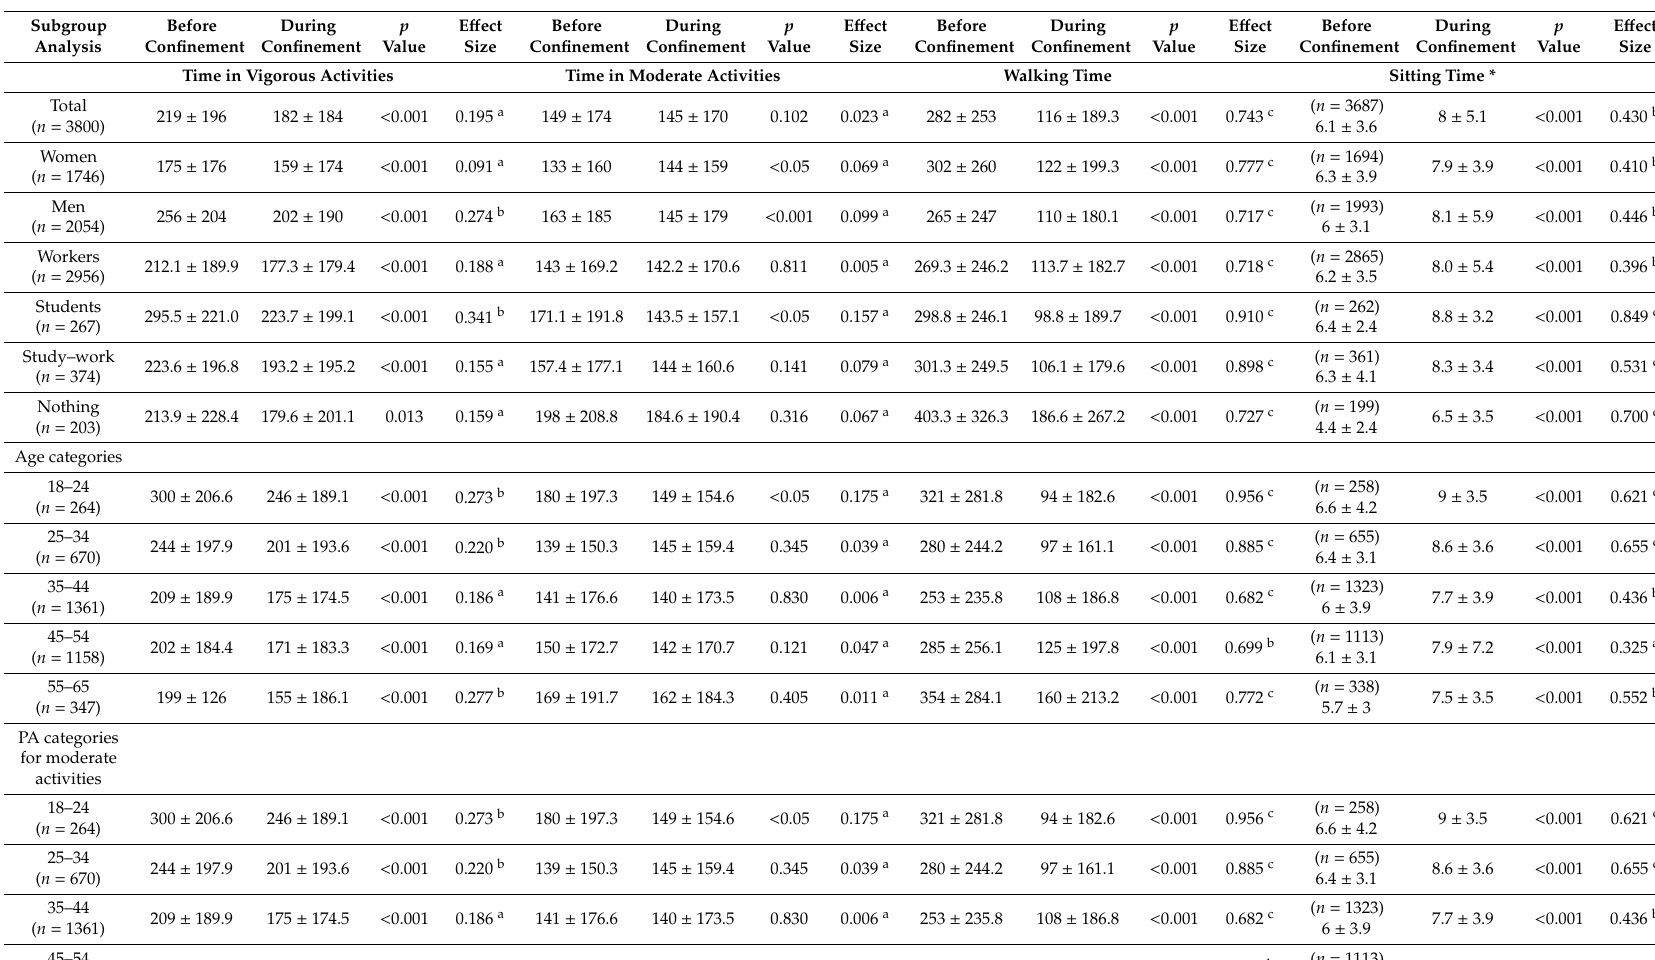
Table 2. Self-reported physical activity (PA) data before and during confinement in all the population and di ff erent